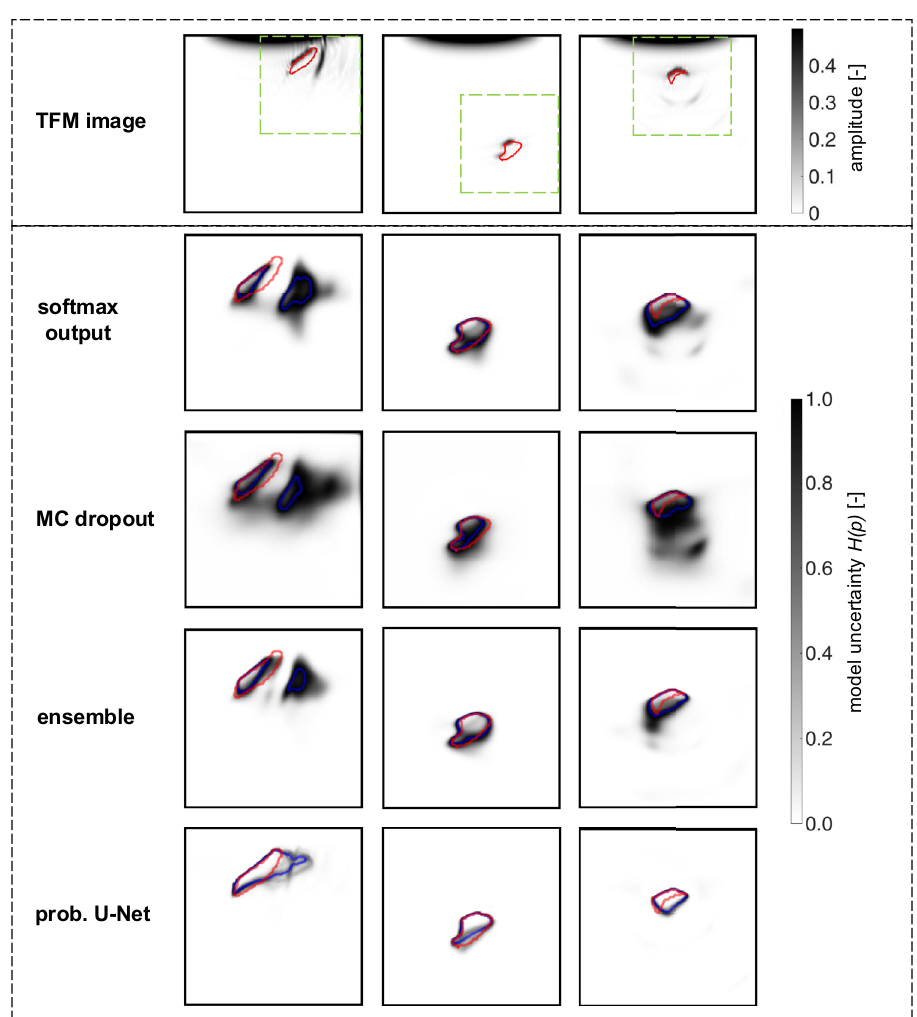
Fig. 8 Model uncertainty H for dataset 3 with the round defect, and microstructure noise